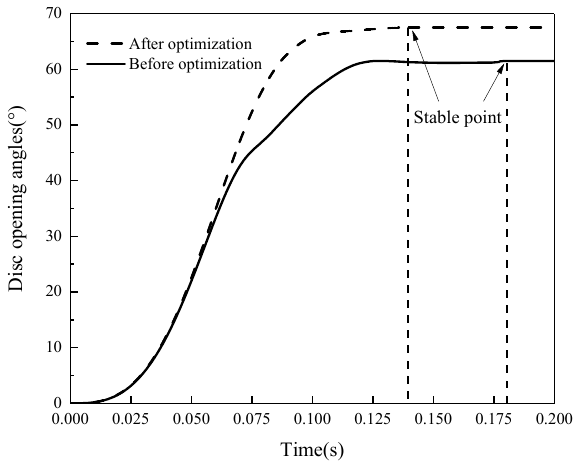
Figure 20. Comparison of relation between disc opening angle and time before and after valve disc optimization.